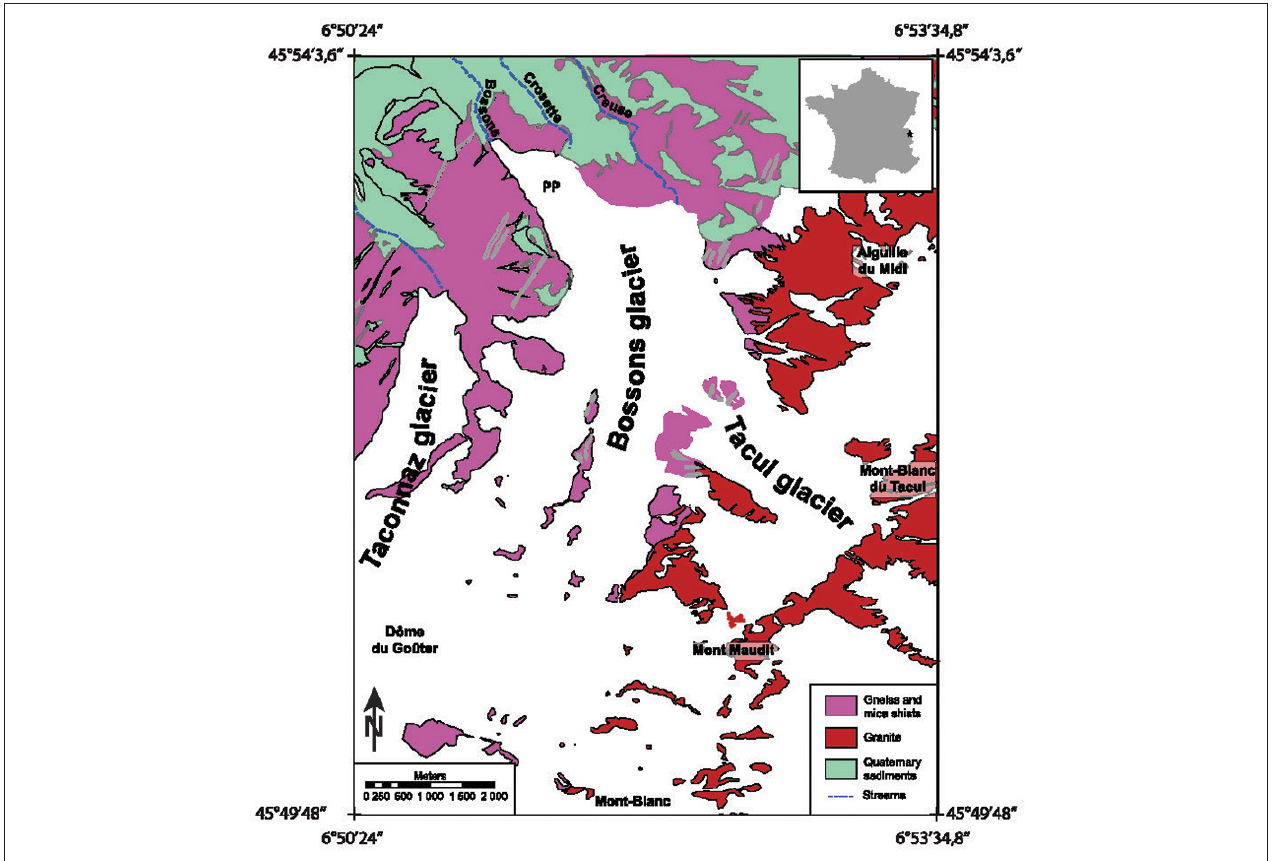
FIGURE 1 | Map showing the Mont Blanc glacier system and simplified bedrock geology around Mont Blanc. The inset shows the location in France. The proglacial Creuse, Crosette and Bossons streams, and Pyramids plateau (PP) are also indicated modified after Guillon et al. (2015).